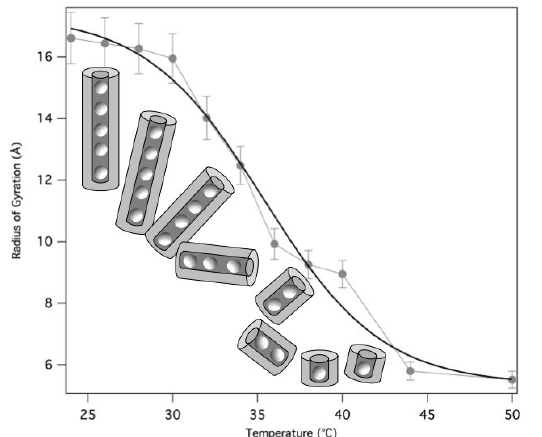
Figure 13. Temperature dependence of the radius of gyration measured in GMPNa 2 samples prepared at 50 mg/mL in 0.5 M KCl. The quadruplex breaking as a function of temperature is illustrated. The continuous line models the fragmentation process by a Hill equation [33].